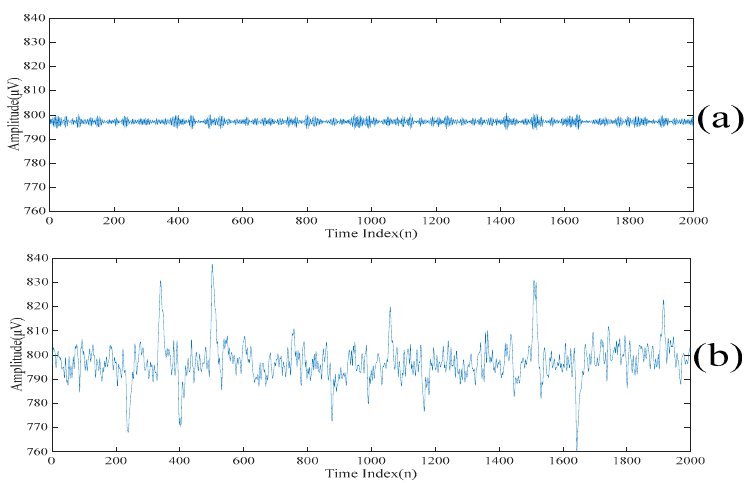
Figure 7. ( a ) The first scale of the electroencephalogram. ( b ) The residue of the